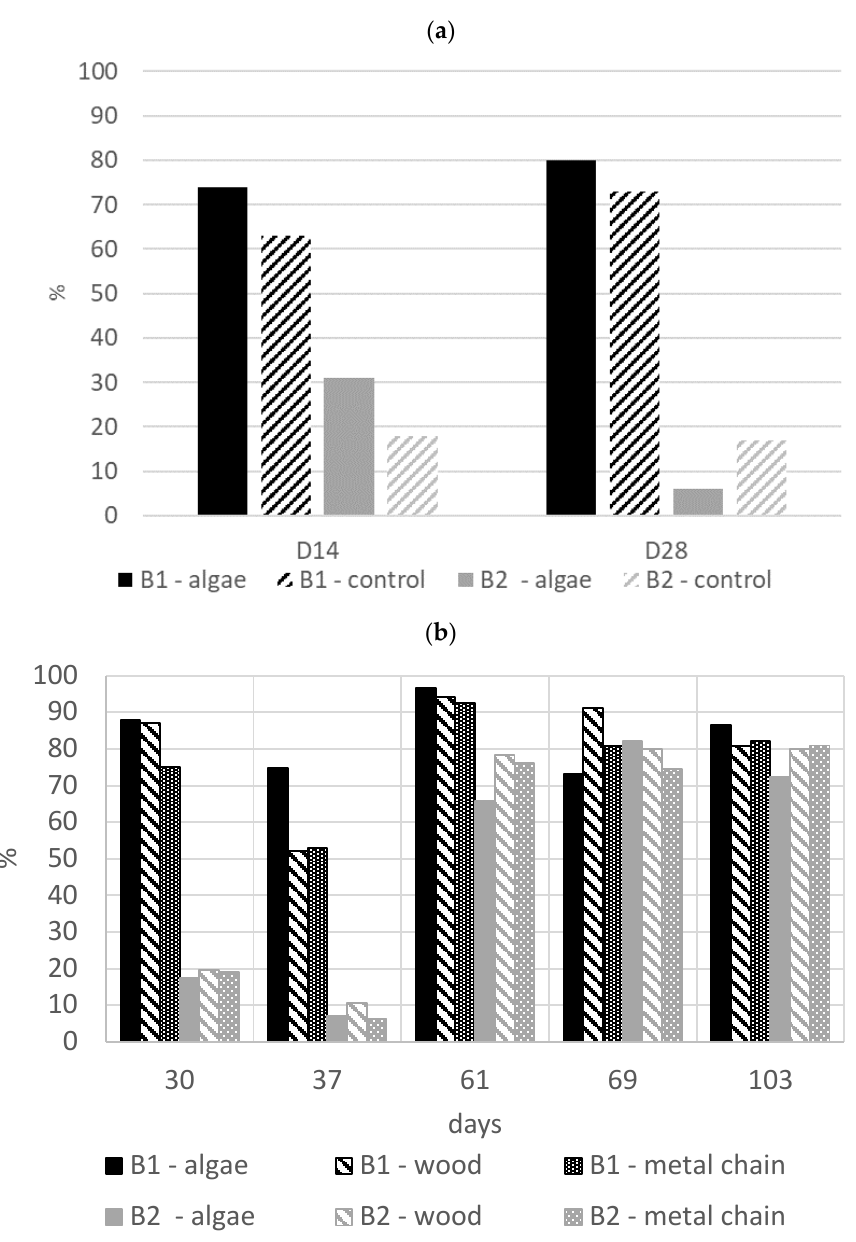
Figure 3. Frequency of pigs with a lesion score of 1–2 (1: moderately and 2: heavily injured) according to enrichment material from ( a ) Day 15 to Day 28; and ( b ) Day 30 to Day 103 ( n = 128 in batch B1 and n = 114 in batch B2).